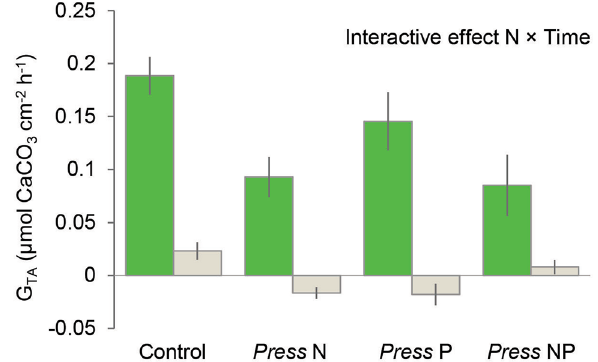
Figure 1. Rates of calcification measured at the end of the experiment (G TA , n = 12) for Acropora intermedia in an experimental study done on Heron Island on the southern Great Barrier Reef. Corals were exposed for 7 weeks under an orthogonal design to continuous ( press ) addition of ammonium (N) and/or phosphate (P). G TA rates (mean ± SE) were measured during day (green bars) and nighttime (grey bars) in one-hour light and dark incubations respectively, and standardized to end-of-experiment tissue surface